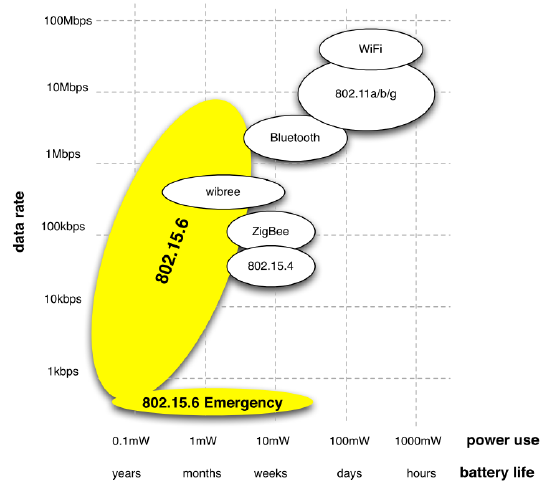
Figure 5. Power and Data Rate Requirements for the IEEE 802.15.6 WBAN Standard